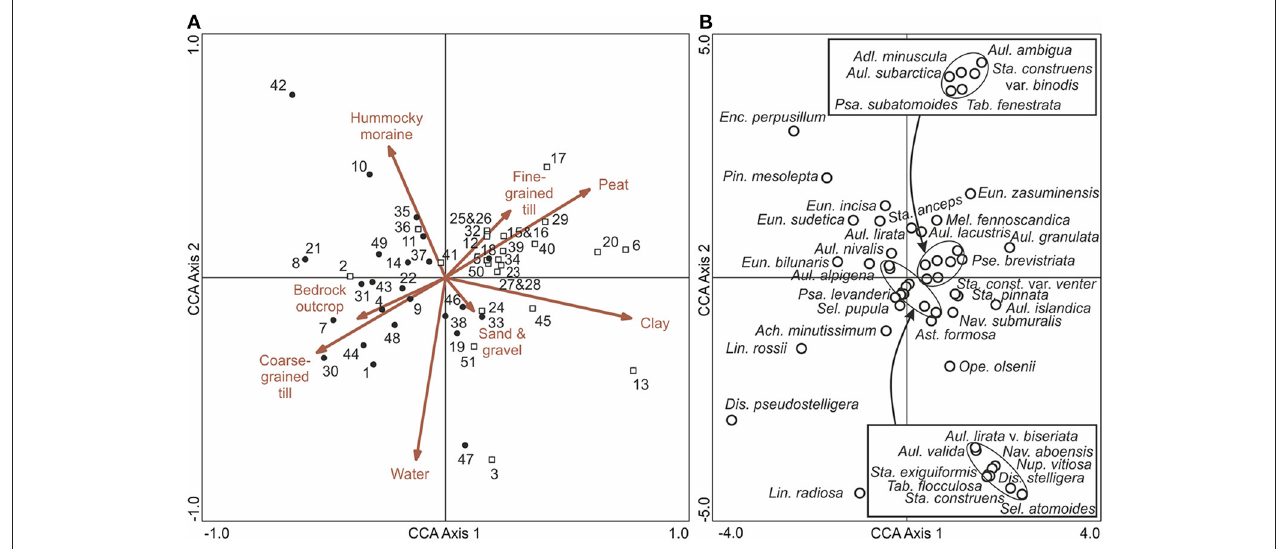
FIGURE 6 | A CCA ordination of bottom (pre-human disturbance) diatom samples with (A) surficial catchment geology (arrows) and (B) diatom taxa (empty circles). In (A) , the empty squares represent sampling sites in the Iisalmi Route and the filled circles represent sampling sites in the adjoining watercourses. Diatom taxa with maximum abundances < 4% in the bottom samples were excluded from (B) for clarity. The names of the diatom taxa encircled in the center of the ordination are given in the boxes. See Table 1 for the names and locations of the sampling